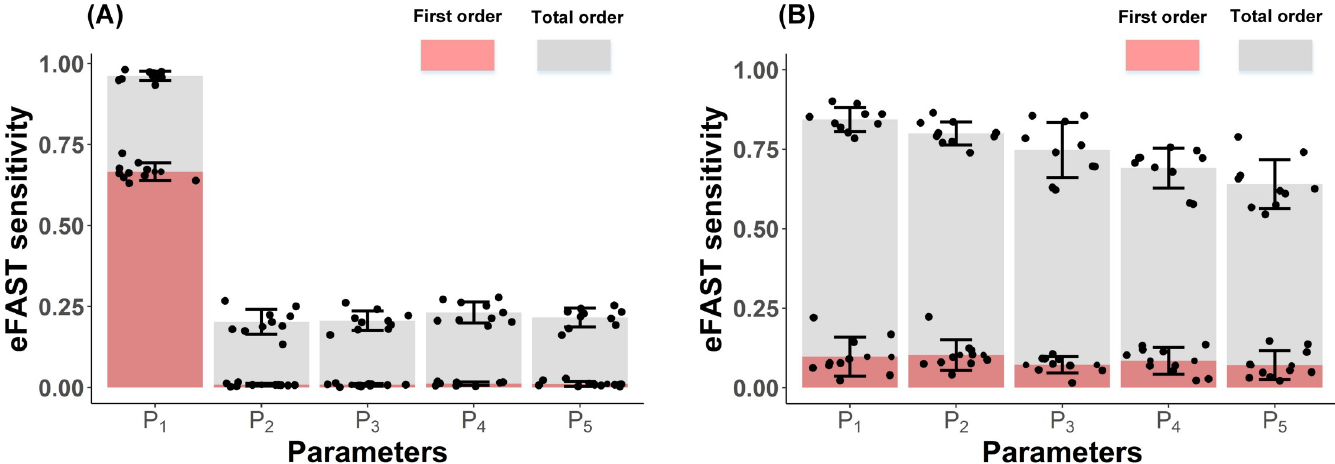
Fig 7. Change in model output based upon selected parameters. (A) eFAST sensitivity based upon full data set; (B) eFAST sensitivity based upon reduced data set that includes only cases with T1D occurrence. The horizontal axes represent five sensitive parameters. The parameters P 1 , P 2 , P 3 , P 4 , P 5 represent the average lifespan of cytotoxic CD8 + T cells in islets, the initial number of damaged β cells ( β init at simulation step 0), the time interval of DCs movement in islets, the maximum number of na ï ve CD8 + T cell binding to DCs, and recruitment rate of DCs circulating in the pancreas, respectively. The vertical axes denote the eFAST sensitivity analysis for the first-order and total-order indexes. The first-order indexes are denoted by pink portions starting from 0, and total-order indexes are illustrated by both grey and pink portions. The first-order index reflects the variance induced by the uncertainty of a single input factor and the total-order index represents the output variance abiding by the interaction between this input factor and other input